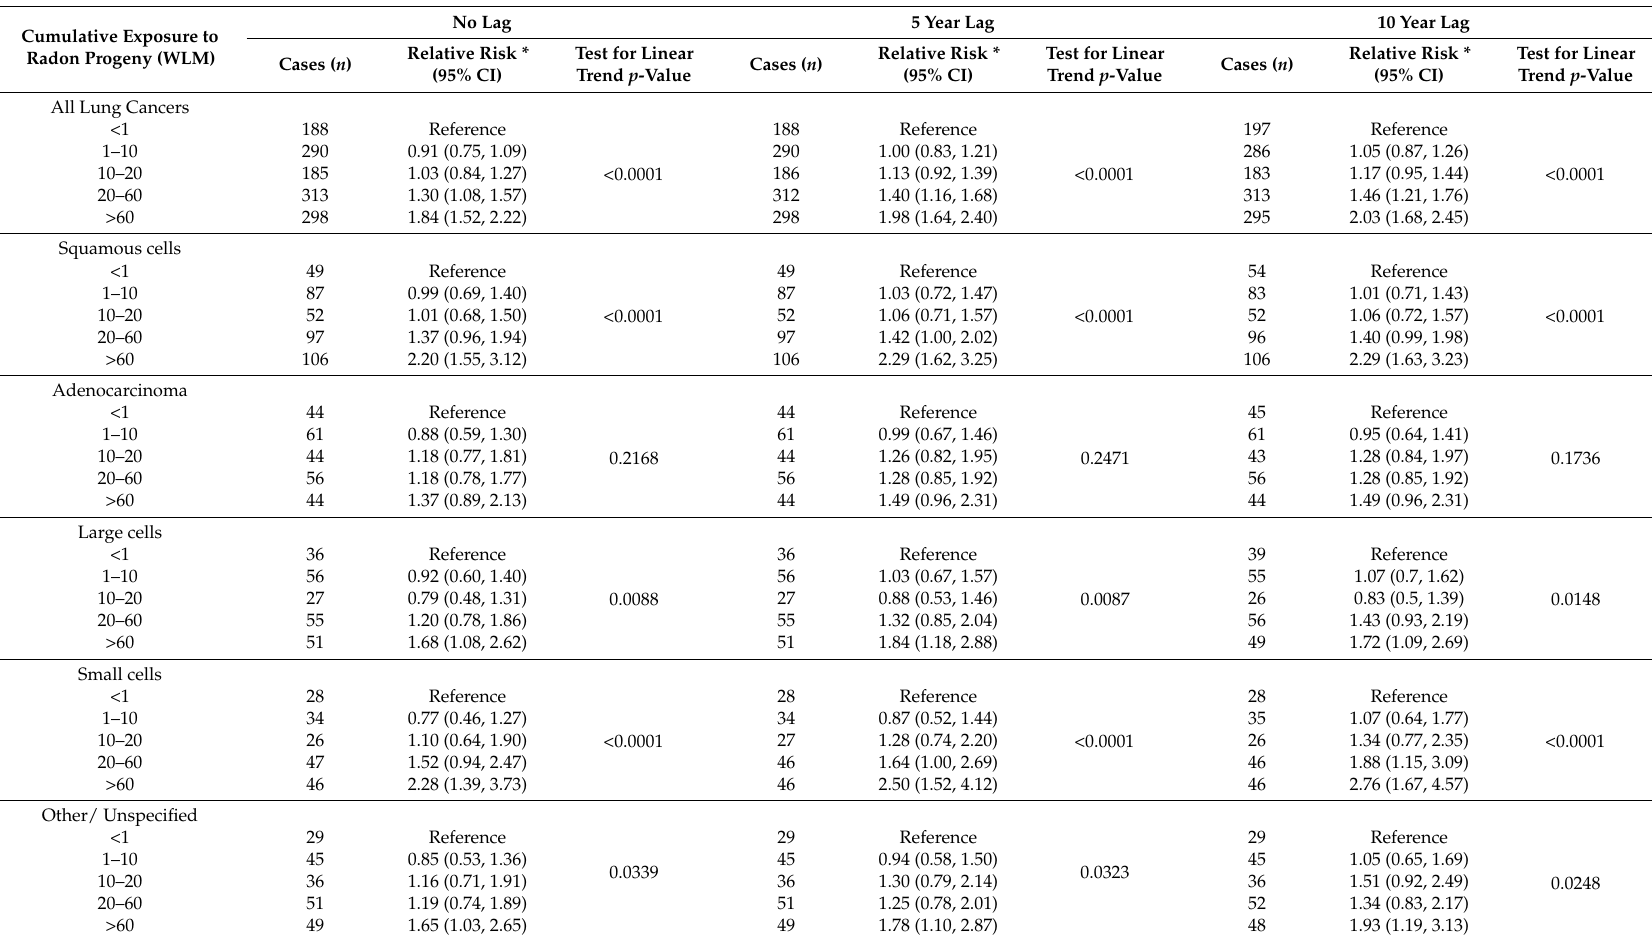
Table 4. Risks associated with cumulative exposure to radon progeny in working level months by lung cancer